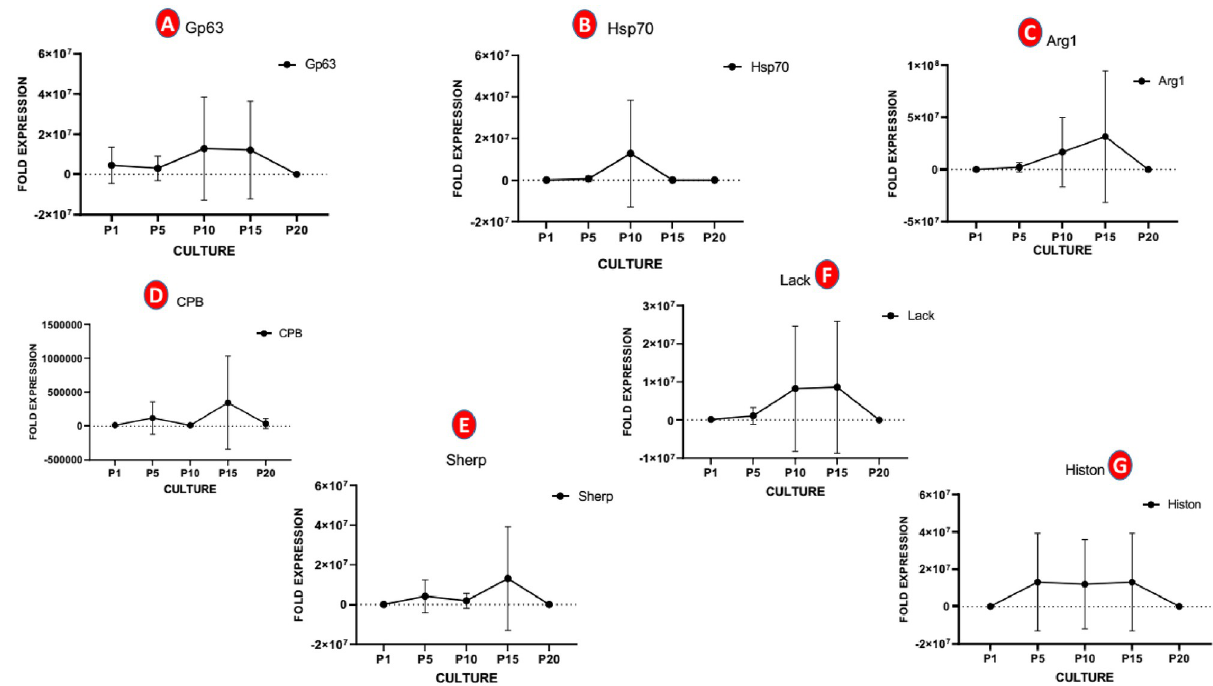
Fig 1. Differential expression pattern analysis of seven VF-related genes (gp63, HSP70, arginase, CPB, LACK, SHERP and histone) in L . major Pro-Stat and Pro-Ppap stages, using quantitative real-time PCR.